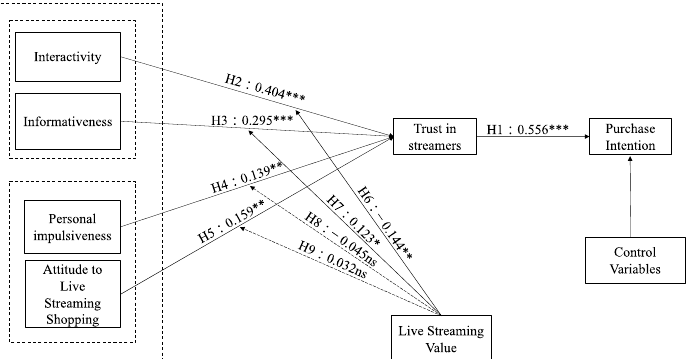
Figure 3. Hypothesis test results. * p < 0.05, ** p < 0.01, *** p < 0.001, ns: not signi fi cant at the 5% signi fi cance level.